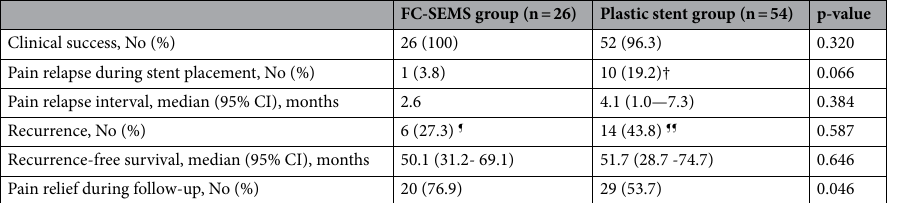
Table 3. Comparison of clinical outcomes. † Excluding 2 patients without clinical success. ¶ Excluding 2 patients with failure of additional stenting for remained stricture. ¶¶ Excluding 3 patients with failure of